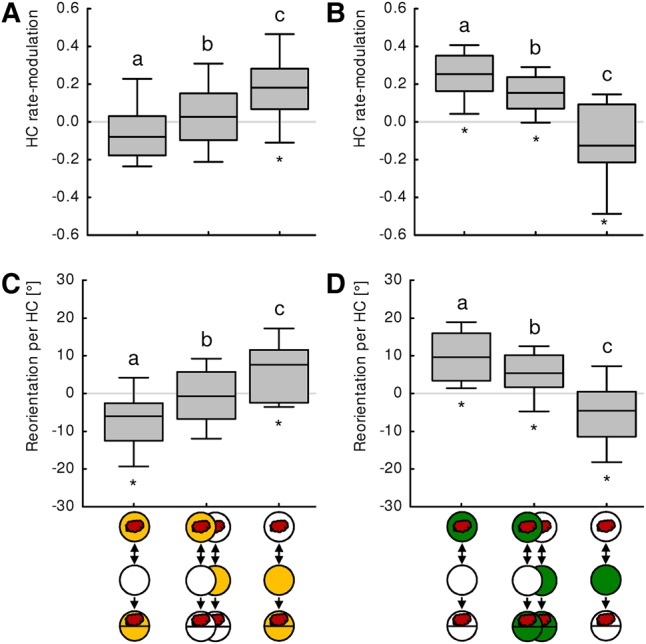
Analysis of head-casting. (A,B) show the HC rate-modulation and (C,D) the Reorientation per HC. (A) After paired aversive training, larvae tend to perform more HCs when heading toward the odor than away from it, yielding a slightly negative HC rate-modulation. After unpaired aversive training, in contrast, more HCs are performed when larvae head away from the odor, resulting in a positive HC rate-modulation. When tested in the absence of quinine, the larvae display an intermediate baseline HC rate-modulation. (B) HC rate-modulation is positive after paired appetitive training, and slightly negative after unpaired appetitive training. When tested in the presence of fructose, the larvae display an intermediate baseline HC rate-modulation. (C) After paired aversive training, larvae after an HC reorient themselves more away from the odor than toward it, indicated by negative reorientation values. After unpaired aversive training, in turn, larvae reorient themselves more toward the odor. When tested in the absence of quinine, the larvae display an intermediate baseline Reorientation per HC. (D) After paired appetitive training, larvae after an HC reorient themselves more toward the odor, whereas after unpaired appetitive training, they reorient themselves more away from the odor. When tested in the presence of fructose, the larvae display an intermediate baseline Reorientation per HC. All displayed features of chemotaxis differ across groups (P < 0.05, df = 2, N = 27, 56, 27, KW). Significant between-group differences (MWU, P < 0.05 corrected according to Bonferroni–Holm) are indicated with lower case letters above the boxes, significant differences to chance level (OSS, P < 0.05 corrected according to Bonferroni–Holm) are indicated by asterisks below the boxes.